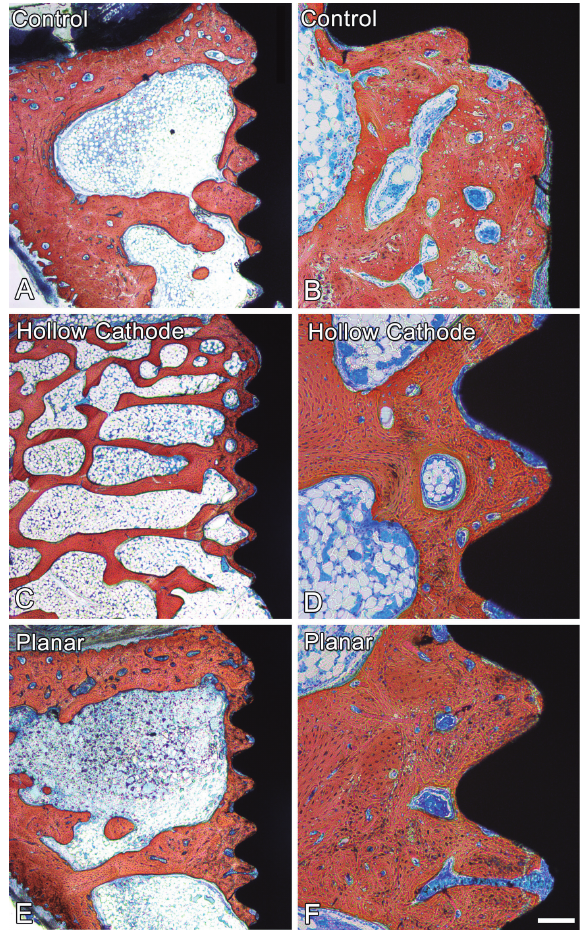
Figure 2- Longitudinal sections of control (A-B); hollow cathode (C-D) and planar (E-F) Ti implant surfaces surrounded by bone and connective tissue, at 6 weeks. E=500 μm and B, D and F=125 μm